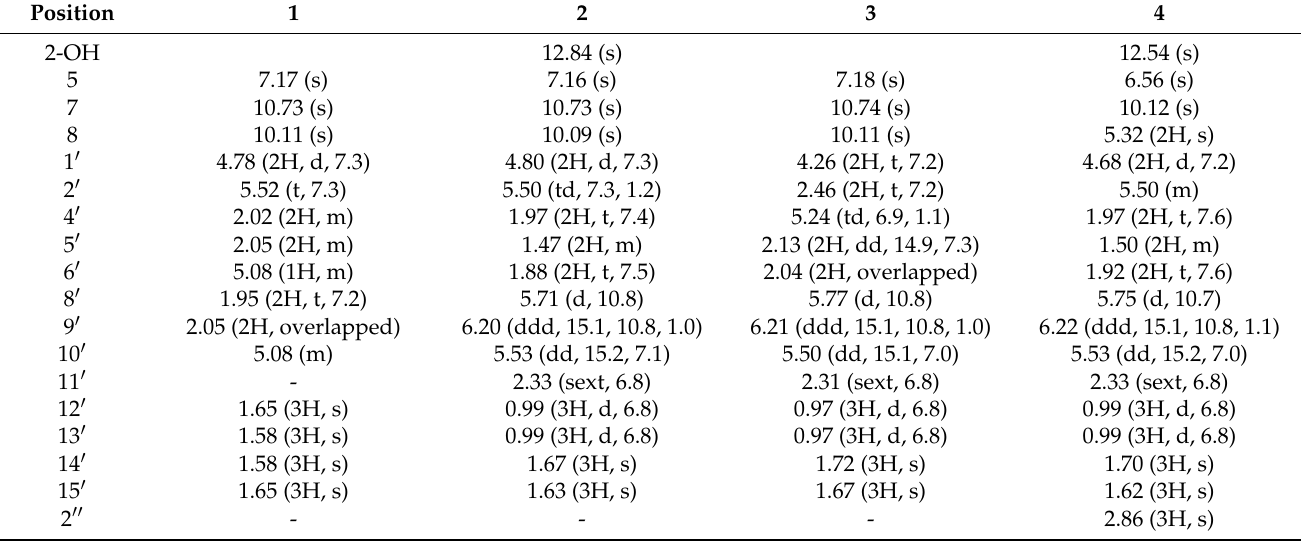
Table 1. 1 H-NMR data for compounds 1 – 4 (500 MHz, Acetone-d 6 , J in Hz).